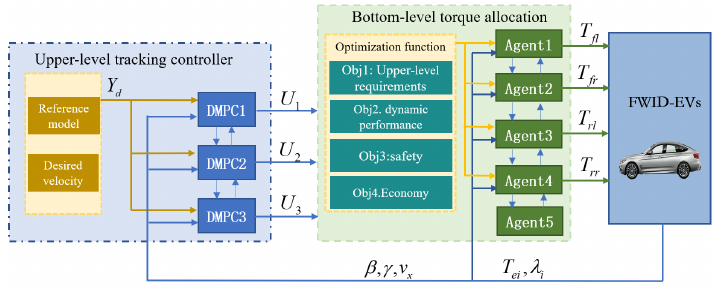
Figure 3. Architecture of the Hierarchical